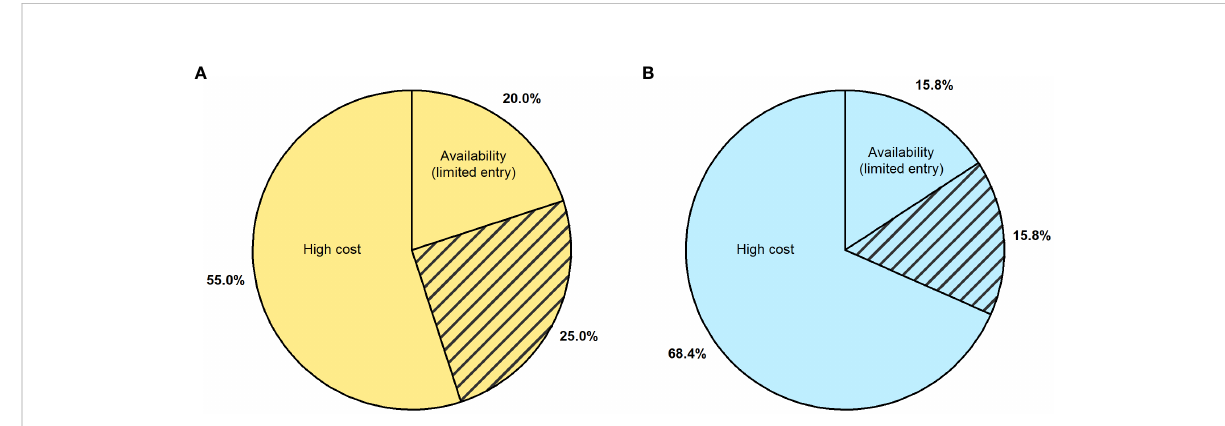
FIGURE 4 Themes from open-ended responses from fi shermen who chose to elaborate on the ability to access or obtain permits as a constraint to adaptive capacity. (A) indicates the percent of responses from market squid fi shermen who chose to elaborate (n=20) and (B) indicates the percent of responses from spiny lobster fi shermen who chose to elaborate (n=19). Each theme is labeled in the pie chart and hashing indicates overlap between two adjacent